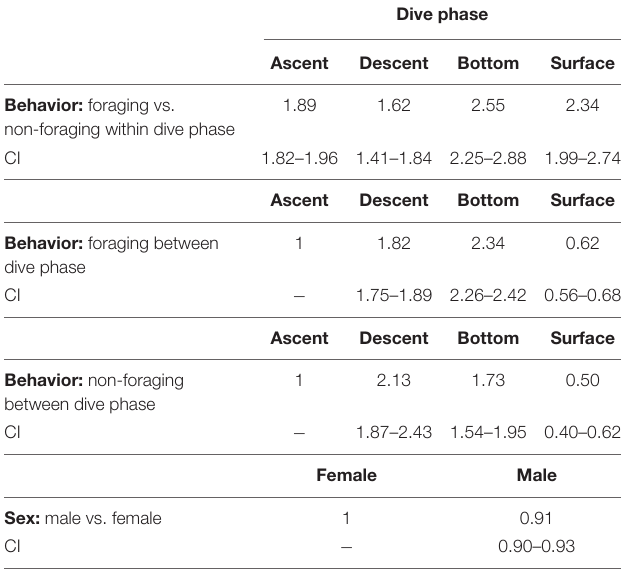
TABLE 5 | Odds ratios for the occurrence of spinning during the four dive phases (descent, ascent, bottom, and surface) during foraging and non-foraging events and for males and